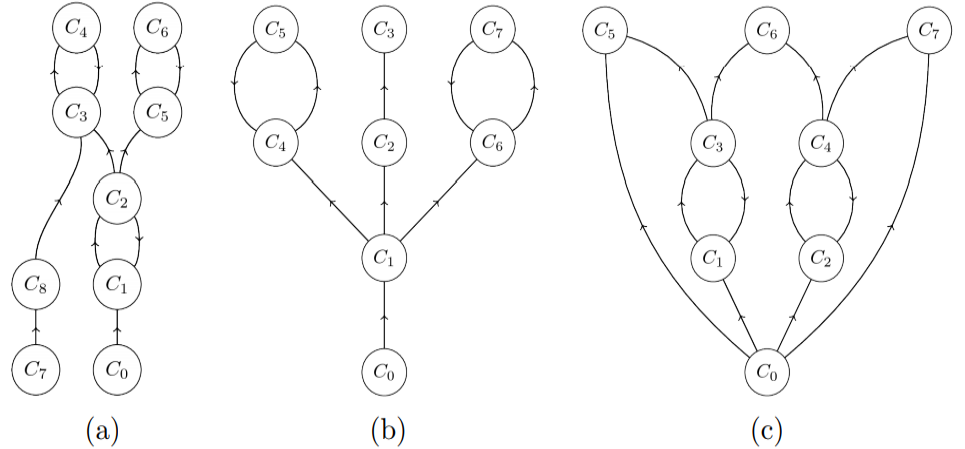
Figure 4. Examples of configuration spaces of M systems with homeostatic components. The root (initial condition) is denoted C 0 . ( a ) The entire graph is a single h -component. Nodes C 7 and C 8 are unreachable from the root but still belong to the h -component. ( b ) A graph with three h -components {C 2 -C 3 }, {C 4 -C 5 }, {C 6 -C 7 }. Nodes {C 0 -C 1 } form the morphogenetic phase M M . ( c ) The entire graph forms a single h -component.